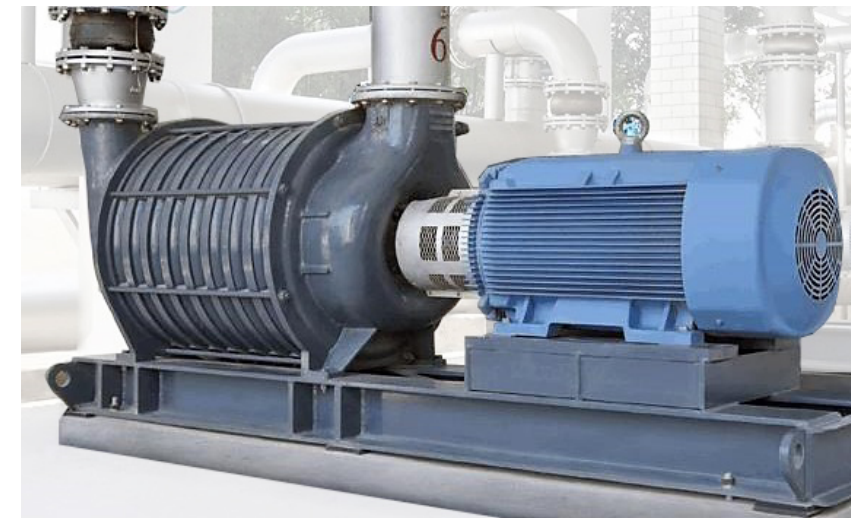
Figure 1. Configuration of a multistage centrifugal